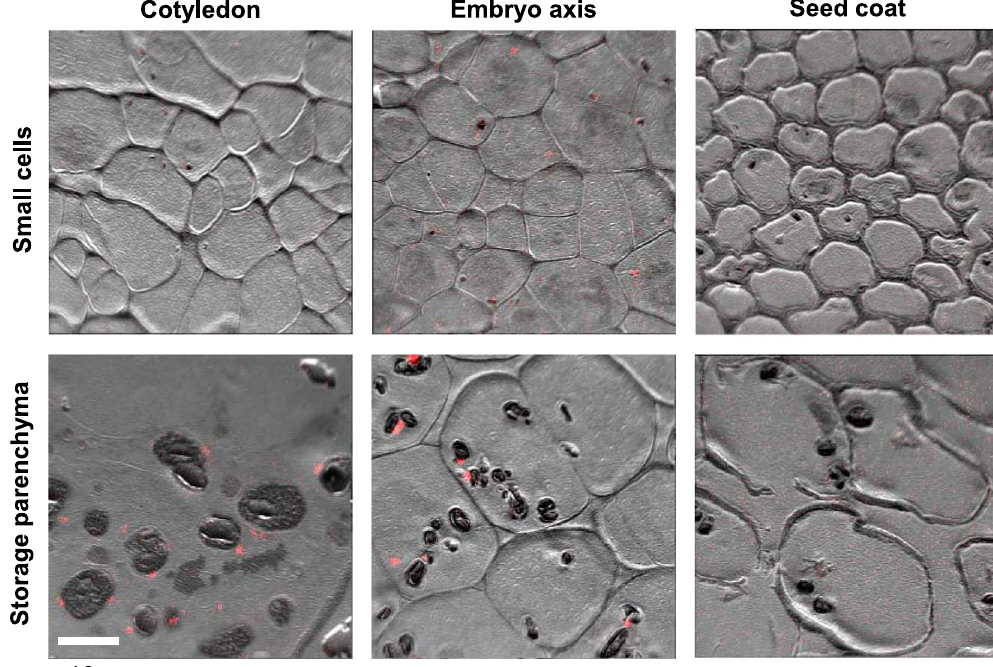
Figure 3. Discrete spots of iron are associated with amyloplasts in pea seeds. NanoSIMS localization of iron in sections of immature pea seeds (JI1194) at 22–24 DAF. The images are representative of 6 analysed regions from the cotyledon, 6 from the embryo axis and 2 regions from the seed coat, showing either small cell types or large storage parenchyma cells. The ion-induced secondary electron image is shown in grey scale and the 56 Fe 16 O − signal is shown superimposed in red. Images with the 56 Fe 16 O − signal only are shown in Figure S5. The dark oval features observed in the larger cells are starch-filled